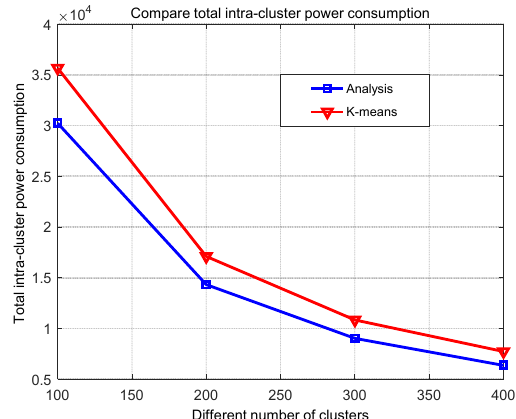
Figure 11. Total intra-cluster power consumption when N = 2000 sensors deployed in a circular sensing area with R BS at the center